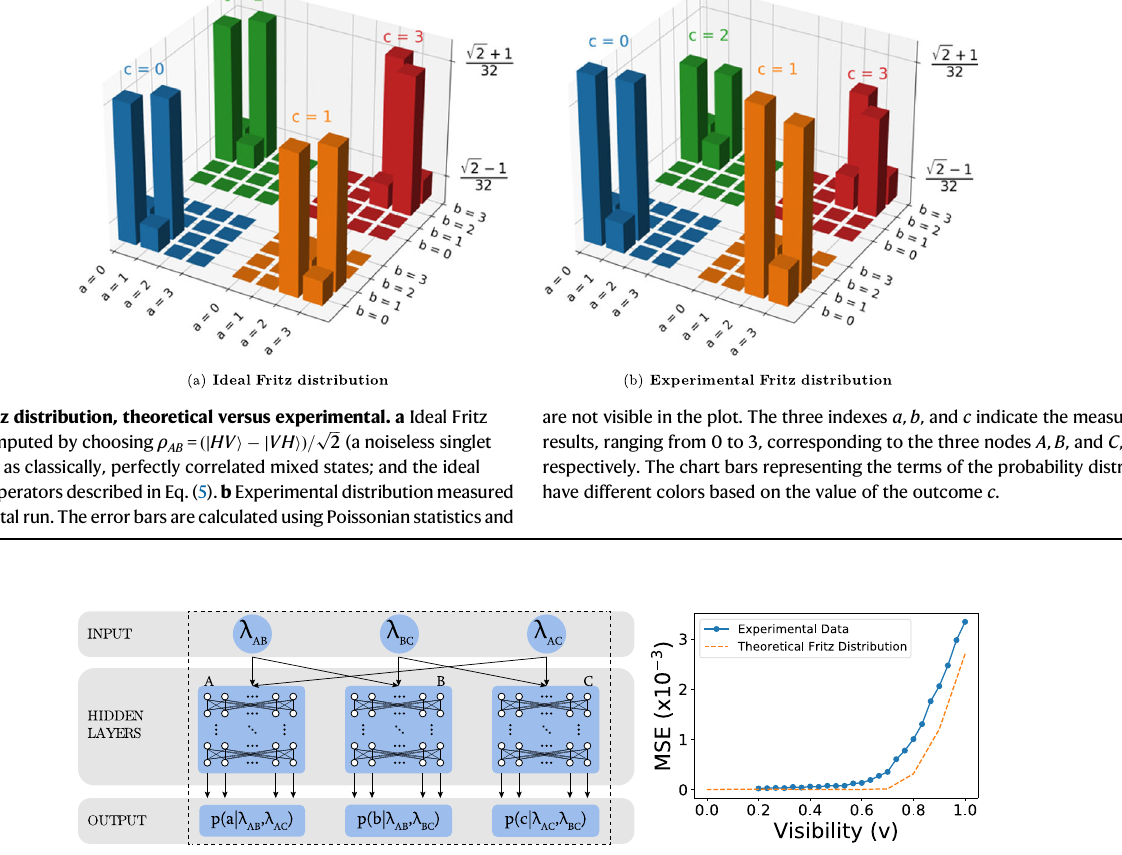
distance achieved by the machine as function of the visibility for the experimental data (solid line) and the comparison with the same distance for theoretical Fritz distribution(dashedline).Fordistinctvisibilityvalues,adifferentMLarchitectureis theoptimumone,strengtheningtheadvantageofusinganassemblyoforacles.See Methods and Supplementary Note 3 for speci fi c details.